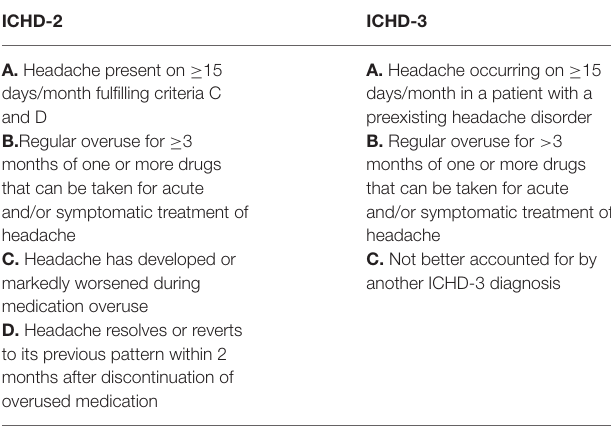
TABLE 1 | Diagnostic criteria for MOH by ICHD-2 (2004) [(35) and by ICHD-3